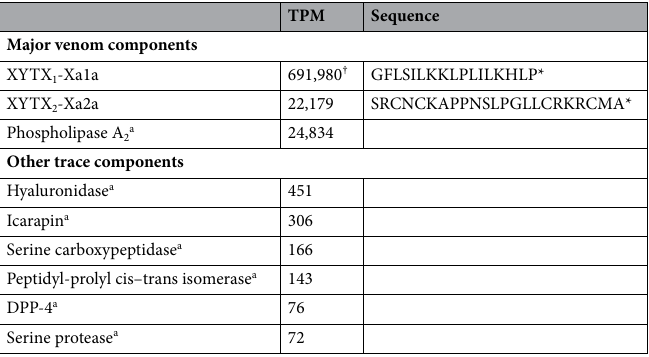
Table 1. Venom components of X. aruana . *C-terminal amidation. † The TPM value is the sum of two paralogous transcripts encoding the same mature peptide. a Detected in reduced, alkylated, trypsin-digested venom sample; sequence not shown. A non-curated summary of the bottom-up sequencing results is included as Supplementary Dataset 1.